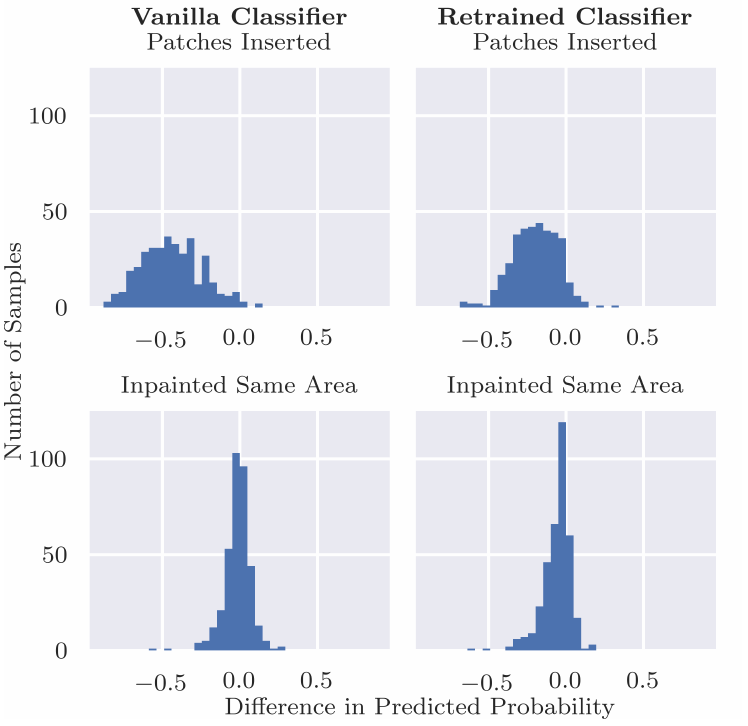
Figure 8. Differences in P ( malignant | x ) from the original malignant images after inserting patches (top row) or inpainting the same area as the patches (bottom row). The changes in probabilities for the inpainted images are much closer to zero than for the images with inserted patches, indicating that the patches themselves are causing the drop in predicted probability rather than the area that they are